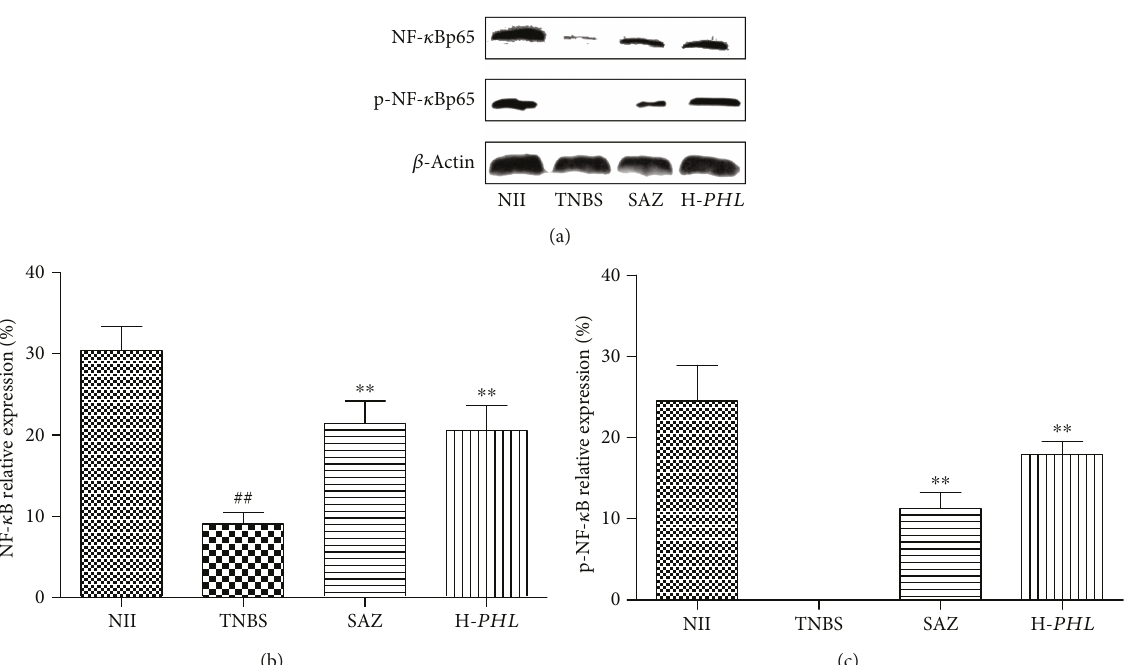
Figure 5: E ff ects of PHL (500mg/kg) and sulphasalazine (SAZ) (120mg/kg) on the colonic production of NF- κ Bp65 and p-NF- κ Bp65 determined by Western blotting. Data are expressed as means ± SD ( n = 5 ); ∗∗ P < 0 01 versus TNBS; ## P < 0 01 versus